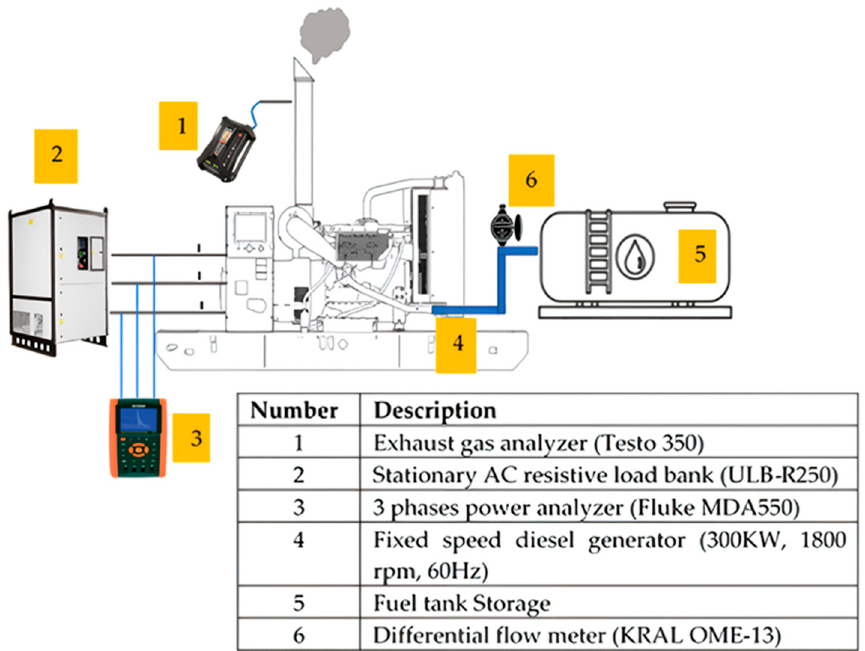
Figure 2. Schematic representation of the study’s experimental design.